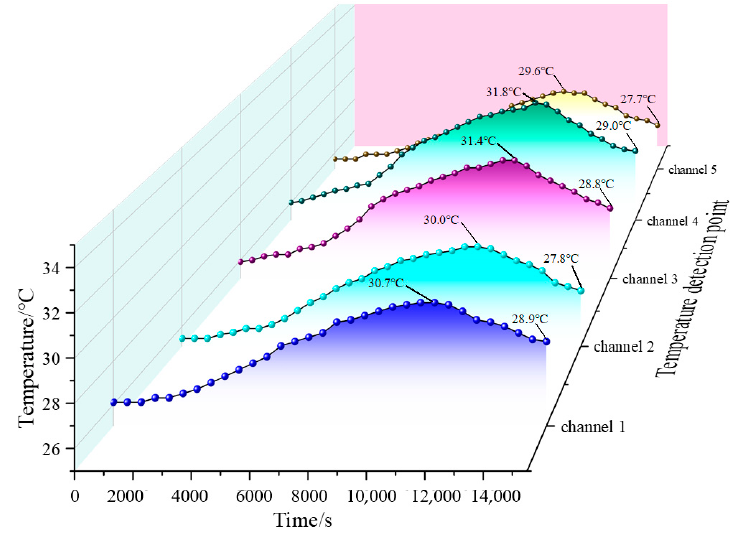
Figure 5. Temperature test of the arrester under continuous operation voltage.